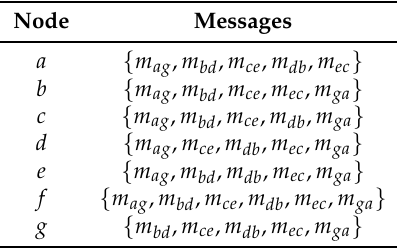
Table 4. Worst case messages to be scheduled per node.